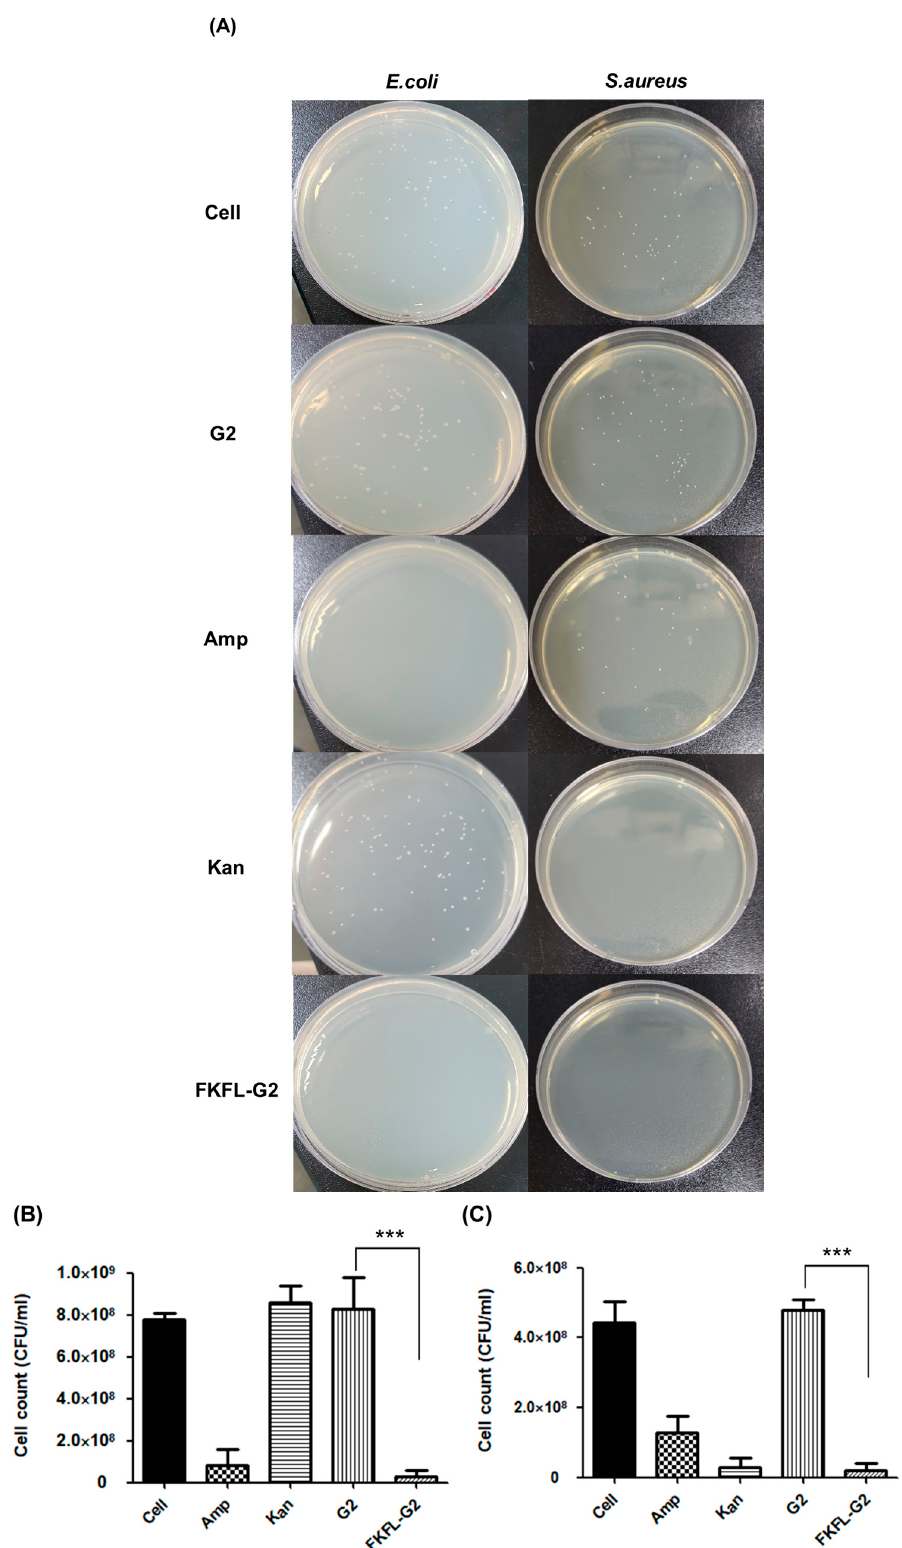
Figure 5. The effect of FKFL-G2, second-generation polyamidoamine (G2 PAMAM), kanamycin (Kan), and ampicillin (Amp) on bacterial colony formation. ( A ) Colony-forming unit assay images. The number of ( B ) E. coli and ( C ) S. aureus colonies. Results are presented as the mean ± SD ( n = 3). Statistical analysis of the experimental data was performed by the Student’s t -test using the GraphPad Prism 5 program (***, p < 0.001).